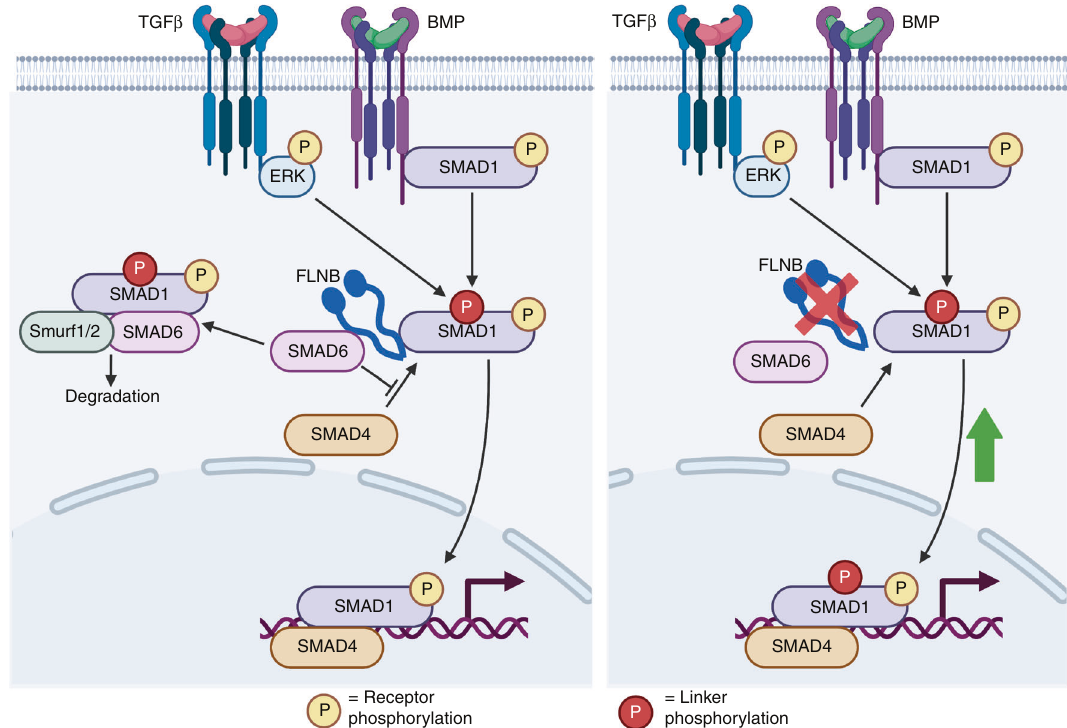
Fig. 7 FLNB stabilizes i-Smad and Smad1 binding, inducing Smad1 degradation. Our model illustrates that under wild-type conditions ( a ), the Smad1 linker region is phosphorylated by TGF β -activated ERK, which tags the molecule for degradation through the recruitment of Smad6, whose interaction with Smad1 is stabilized by FLNB. In the absence of FLNB ( b ), linker phosphorylated Smad1 is degraded less ef fi ciently and allowed to induce increased transcription of nuclear